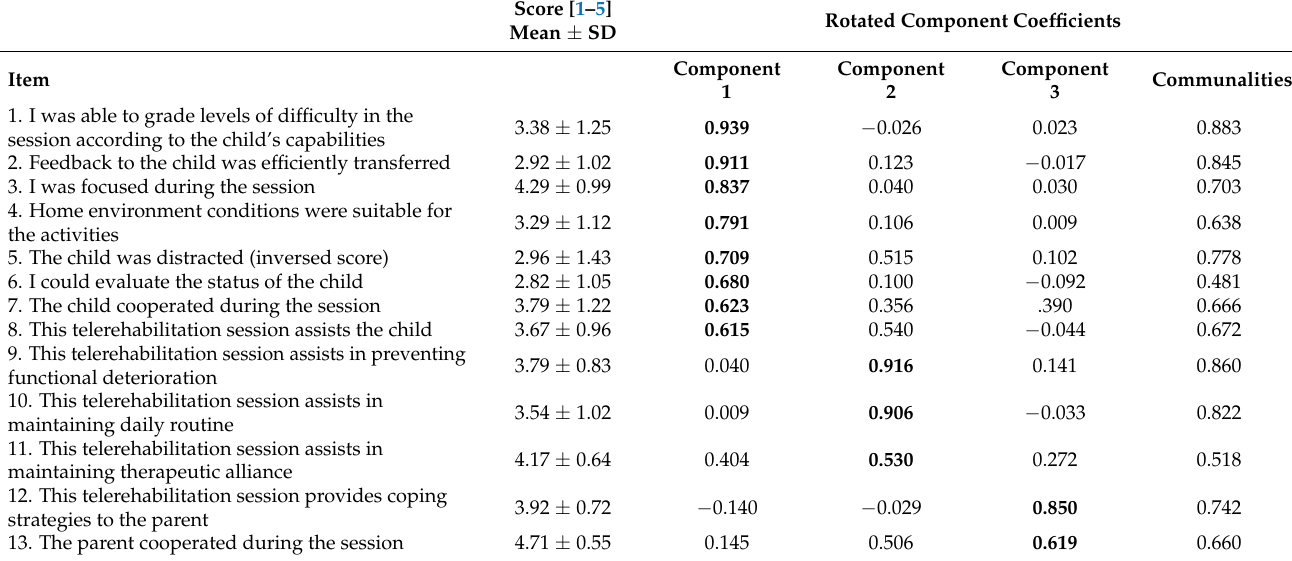
Table 2. Responses from The Clinician Evaluation of Telerehabilitation Service (CETS) (N = 67) and results from PCA. Rotated structure matrix for PCA with Varimax rotation of a three-component questionnaire. In bold are the maximal loadings for each